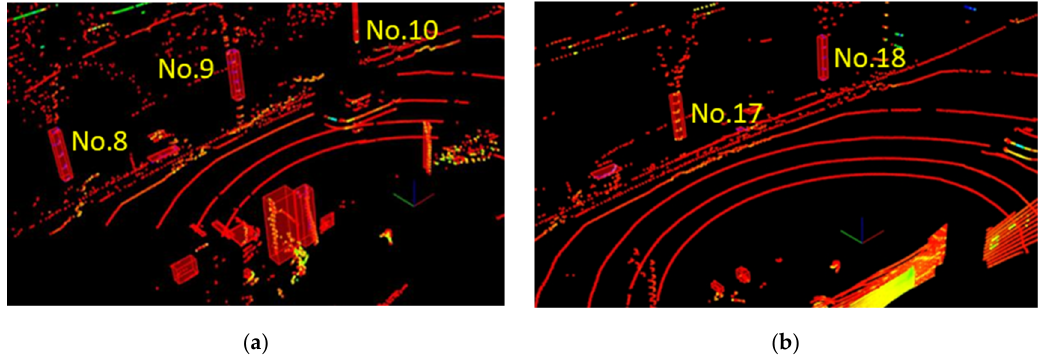
( b ) Figure 10. Matched targets between the single frame and map-based target detection results. ( a ) The No. 0–30 of matched targets for target detection in global map. ( b ) The number of detected and matched targets in each frame. Table 1. The number of detected and matched targets for single frame target detection. Mean